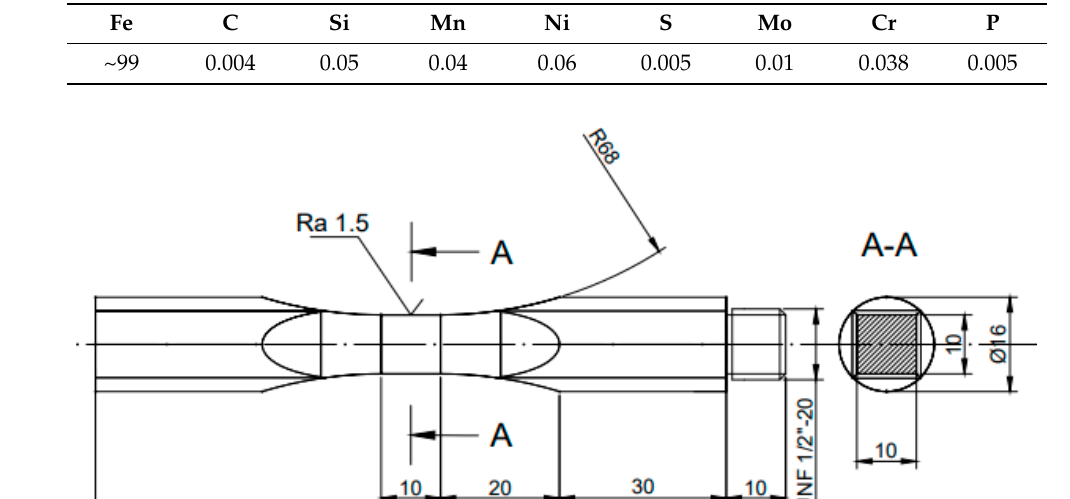
Table 1. The chemical composition of ARMCO iron (wt.%).